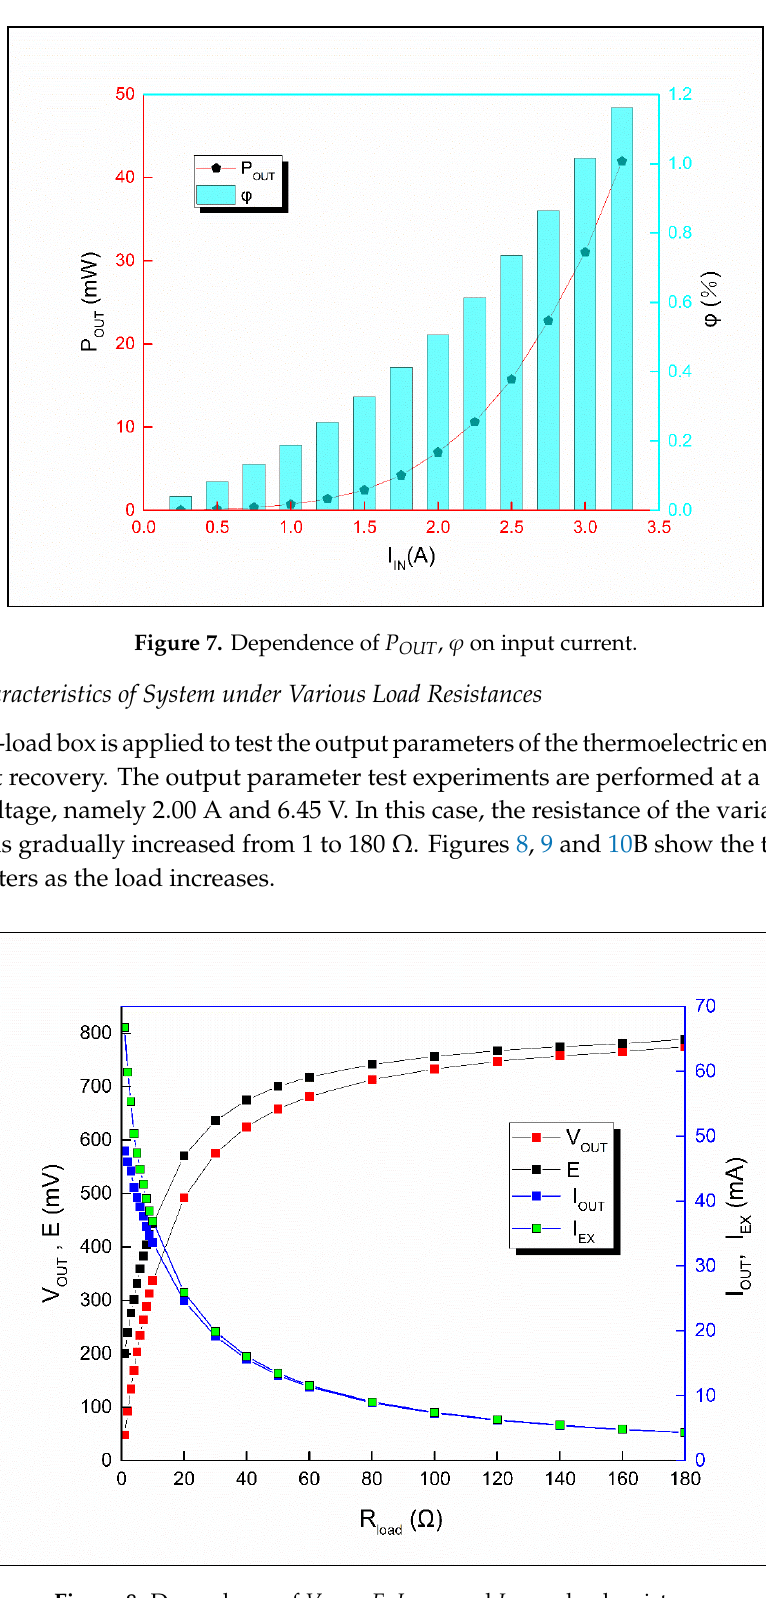
Figure 6. Dependence of OUT V , OUT I on input current.